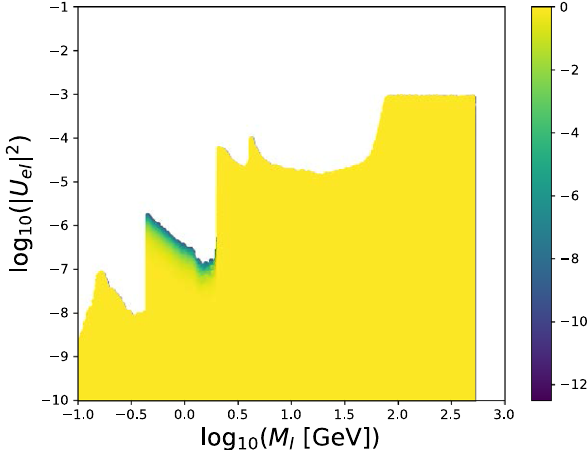
Fig. 20 Partial likelihood from direct searches with CHARM, e - channel, in the M I − | U eI | 2 plane